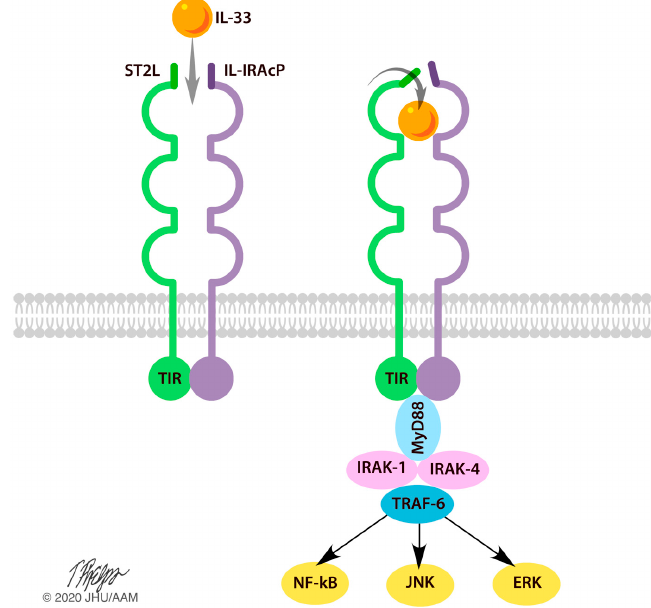
Figure 1. IL-33 mechanism of activation. The ST2L / IL-1RAcP receptor complex is found on the cell membrane of Th2 cells, ILC2s, and FoxP3 + Tregs. Upon binding to IL-33, this receptor complex undergoes a conformational change to allow for activation of the inflammatory response. A cascade of events unfolds, in which MyD88, IRAK-1, IRAK-4, and TRAF-6 become activated. Subsequently, NF-kB, JNK, and ERK / MAPK pathways are activated to produce a pro-inflammatory response. TIR: Toll interleukin receptor; MyD88: Myeloid di ff erentiation primary response protein; IRAK: Interleukin receptor-associated kinase; TRAF: TNF-receptor-associated factor 6; NF- κ B: Nuclear factor kappa light chain enhancer; JNK; c-Jun N-terminal kinases; ERK: Extracellular signal-regulated